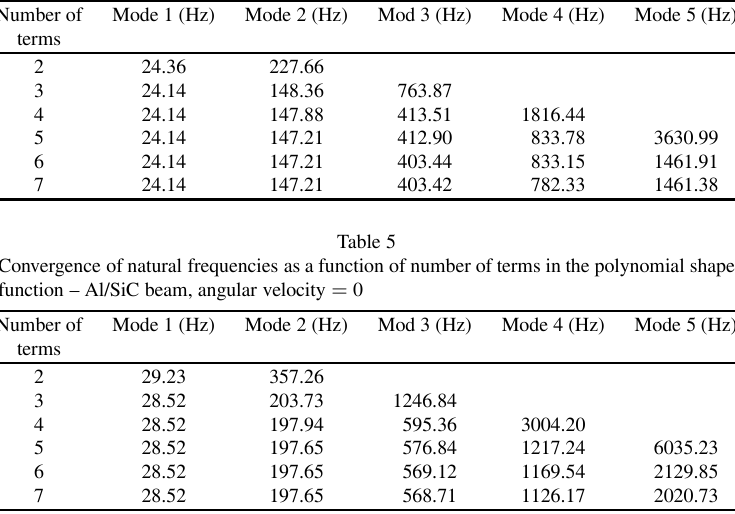
Table 6 Convergence of natural frequencies as a function of number of terms in the polynomial